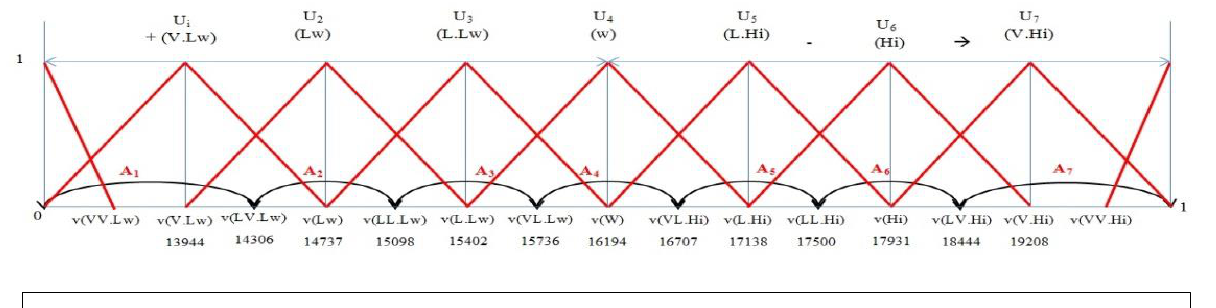
Where A are similar fuzzy intervals i .